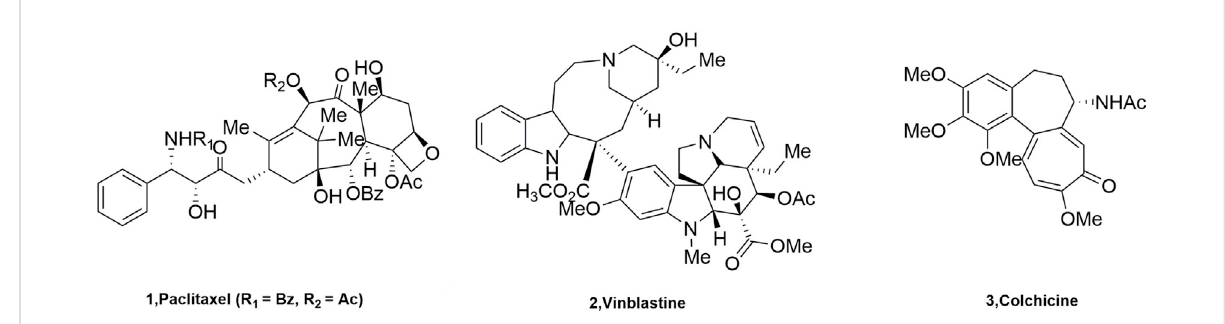
The structure of tubulin inhibitors.